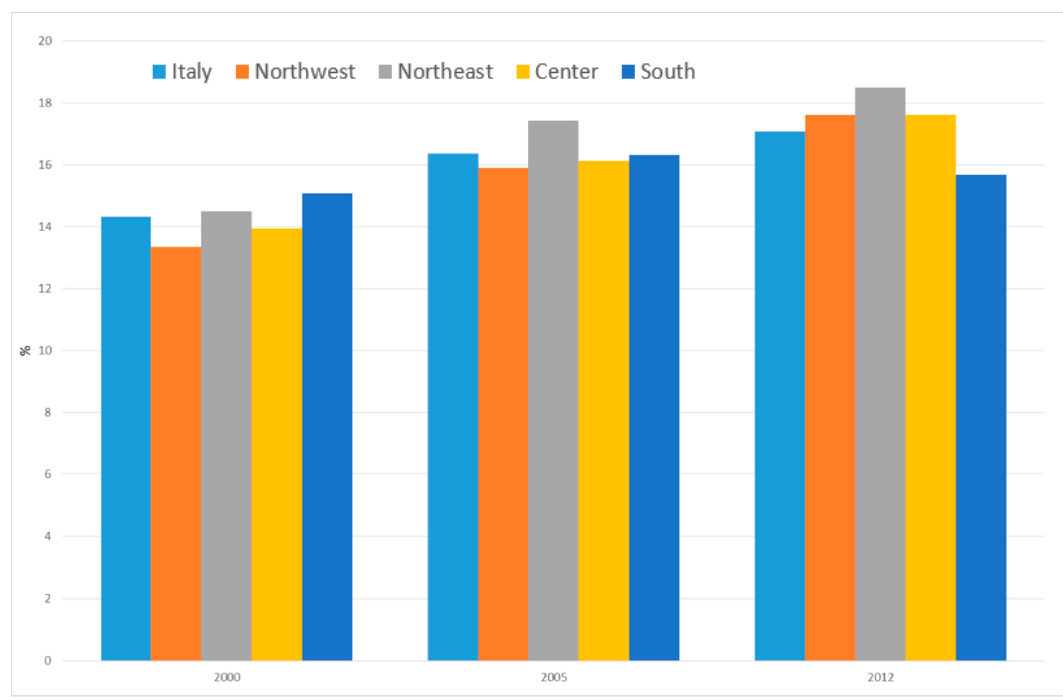
Figure 9. Percentage of women in childbearing age (15–49 years old) who breastfed in Italy overall and by area of residence. Italy, 2000–2012. Source: National Health Interview Survey (NHIS) of the Italian National Institute of Statistics (Istat).